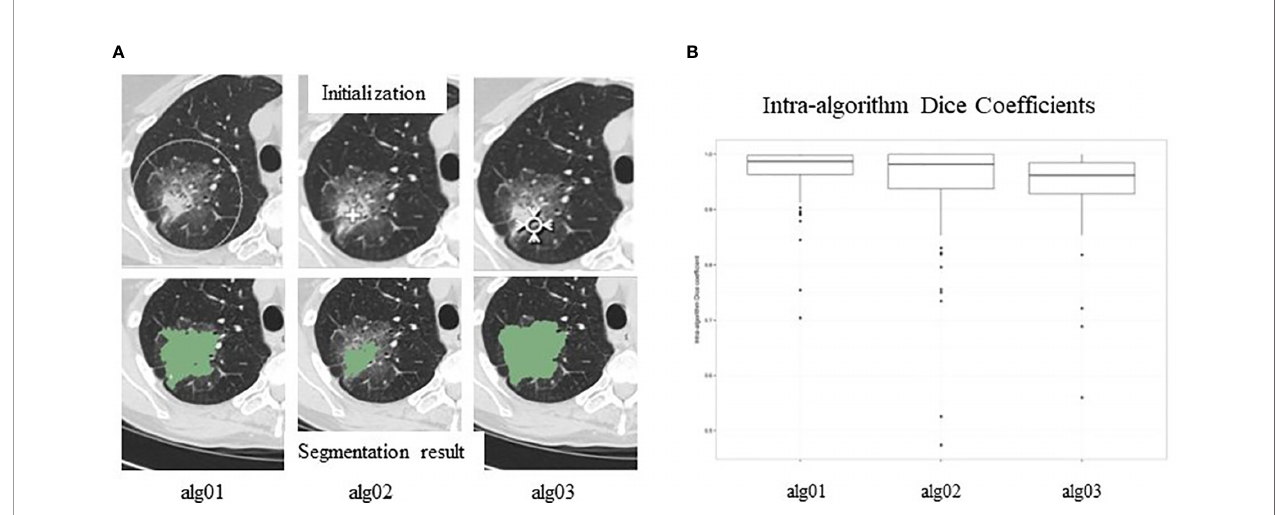
FIGURE 5 | (A) . Inter-reader variability in segmentation. Top panel: manual initializations (seed point/ROIs) of three segmentation algorithms; bottom panel: corresponding segmentation results. (B) Intra-reader variability in segmentation. Segmentation results are affected by seed points/ROIs. Reproduced with permission from